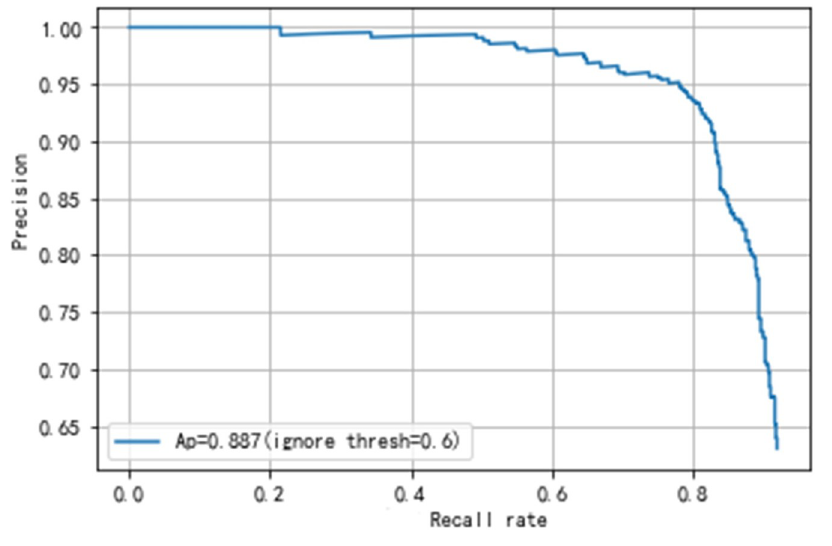
Fig 5. The PR curve of YOLOv3 and our